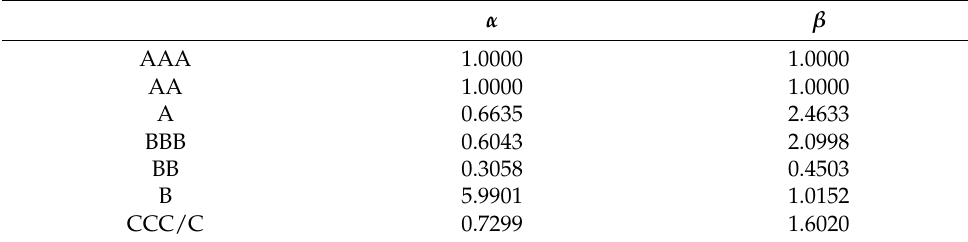
Table 4. Optimized parameters.